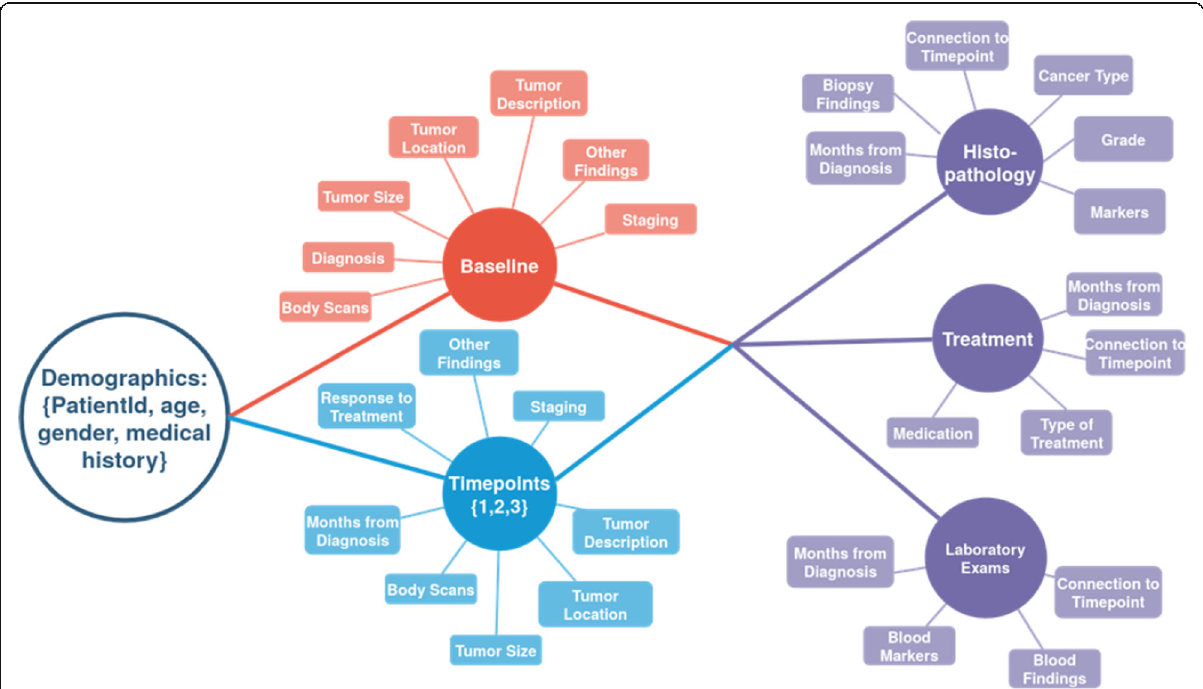
Fig. 3 The design of the INCISIVE data